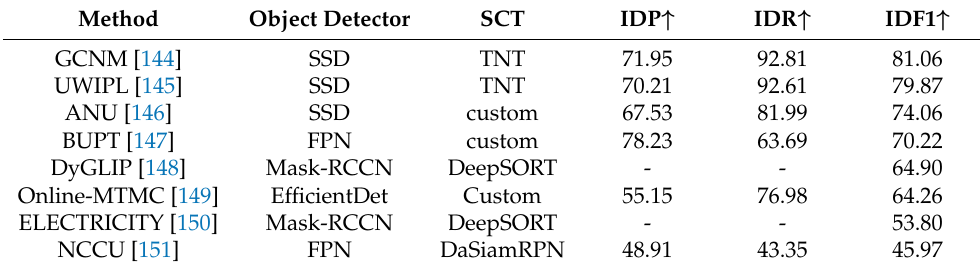
Table 3. Performance of Typical Algorithms on BDD100K